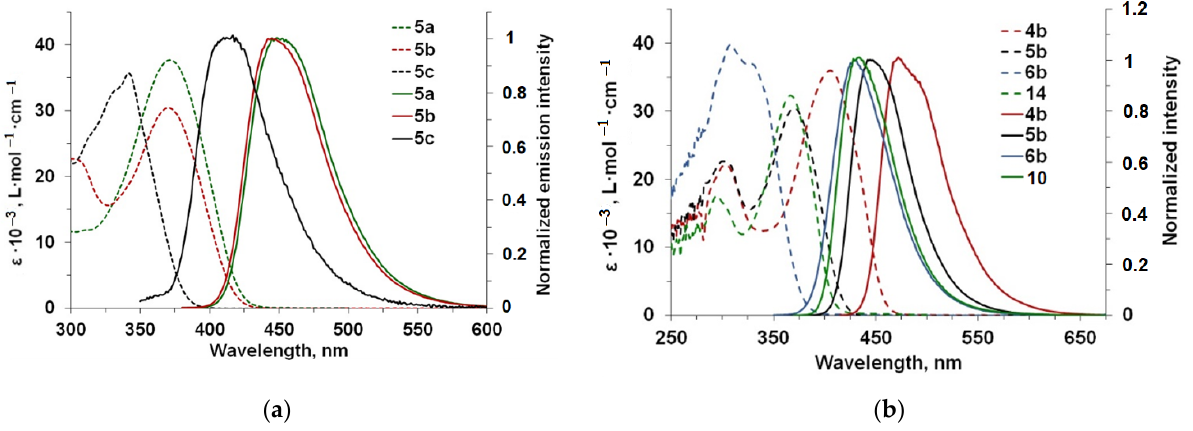
Figure 4. ( a ) UV/Vis (dashed line) and photoluminescence (solid line) spectra of compounds 5a–c in toluene; ( b ) UV/Vis (dashed line) and photoluminescence (solid line) spectra of Ph 2 N derivatives 4b , 5b , 6b and 10 in toluene.